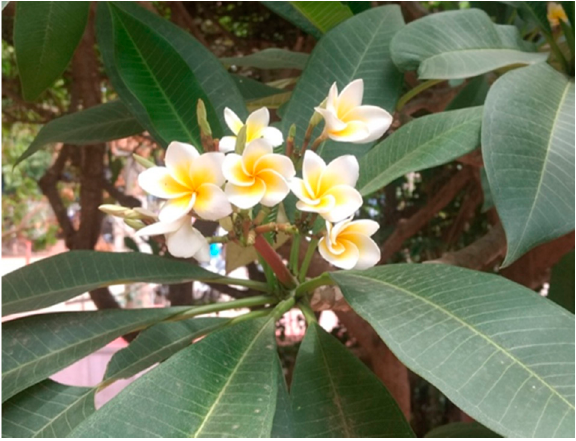
Figure 1. Plumeria alba plant